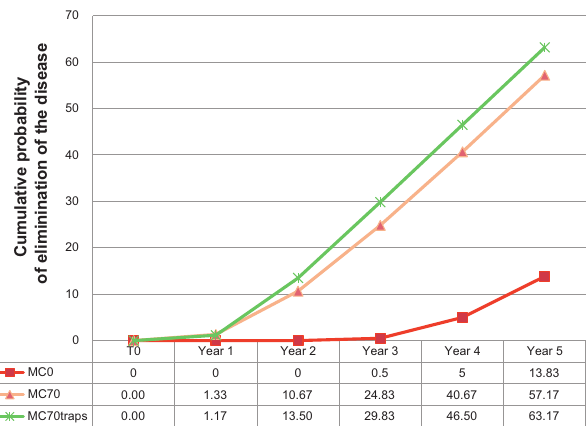
Figure 6. Cumulative probabilities of elimination of endemic events without any public health action (MC0), with a medical survey with 70% of medical cover (MC70), and with medical survey associated to vector control (MC70